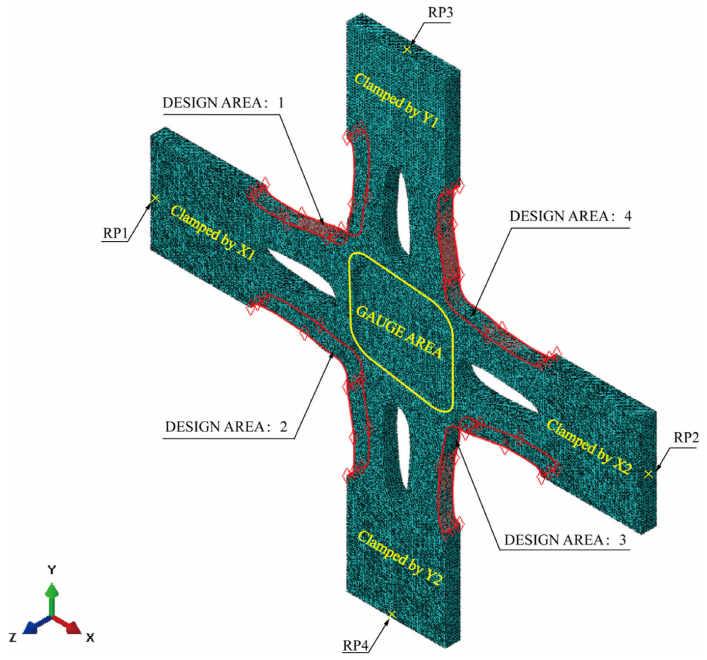
Figure 8. The finite element model for shape